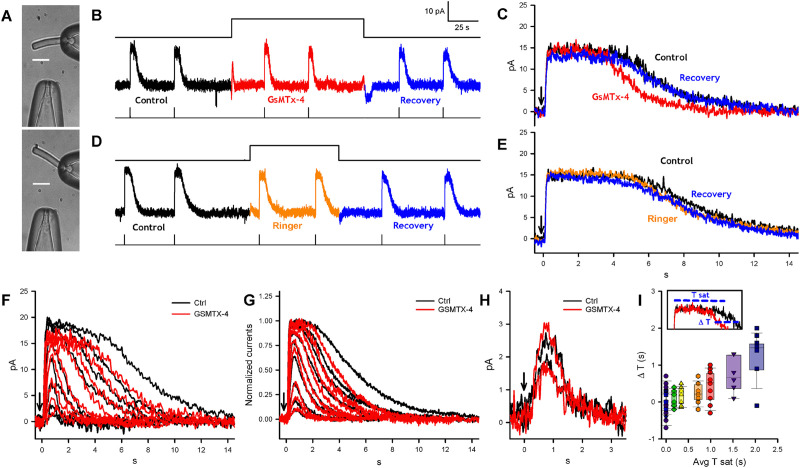
The effect of MSC blocker GsMTx-4 on photoresponses from Xenopus rods.(A) IS of a rod trapped in a recording pipette and a glass pipette connected to a picospritzer, containing GsMTx-4. Upon the activation of the picospritzer, the rod OS was tilted and returned to its initial position (scale bar, 20 μm). (B) The photocurrent elicited by flashes of about 2,500 R*/rod before, during, and after an exposure to GsMTx-4 lasting 120 s. (C) Exposure to GsMTx-4 (red trace) shortens the duration of the bright-flash photoresponse by more than 1 s compared with those obtained immediately before (black) and immediately after (blue) exposure to GsMTx-4; mean duration (measured as the difference in time between 50% of the falling phase and 50% of the rising phase of the response) 4.7 ± 1.8 s in control and 3.4 ± 1.3 s in GsMTx-4 (p < 0.001). (D and E) As in B and C, but the picospritzer injected Ringer solution. Mean duration 6.2 ± 1.7 s in control and 5.9 ± 1.9 s in Ringer (ns). (F) Comparison of photoresponses in control conditions (black traces) and in the presence of GsMTx-4 (red traces) for 1 cell exposed to flash of approximately 5, 10, 25, 50, 100, 250, 500, 1,000, and 2,500 R*/rod. (G) As in F, but in this case each trace was averaged over photoresponses obtained from 6–7 different rods. The amplitude of the maximal photoresponse was normalized to unity for recordings both in Ringer (black traces) and in the presence of GsMTx-4 (red traces). (H) The effect of GsMTx-4 on dim flash photoresponses for one cell; the flash intensities were 5 and 10 R*/rod (n = 6–7). (I) Relation between the GsMTx-4-induced shortening (ΔT) of photoresponse duration and the Tsat of the response. For 250, 500, 1,000, and 2,500 R*/rod, the shortened time courses were of 0.3 s, p < 0.05; 0.5 s, p < 0.01; 0.7 s, p < 0.05; and 1.3 s, p < 0.001, respectively. In all experiments, the concentration of GsMTx-4 in the picospritzer pipette was 5 μM, we estimate that at the rod OS was in the micromolar range; n = 6–7 (S4 Data). GsMTx-4, M-theraphotoxin-Gr1a; IS, inner segment; MSC, mechanosensitive channel; OS, outer segment; Tsat, saturation time.